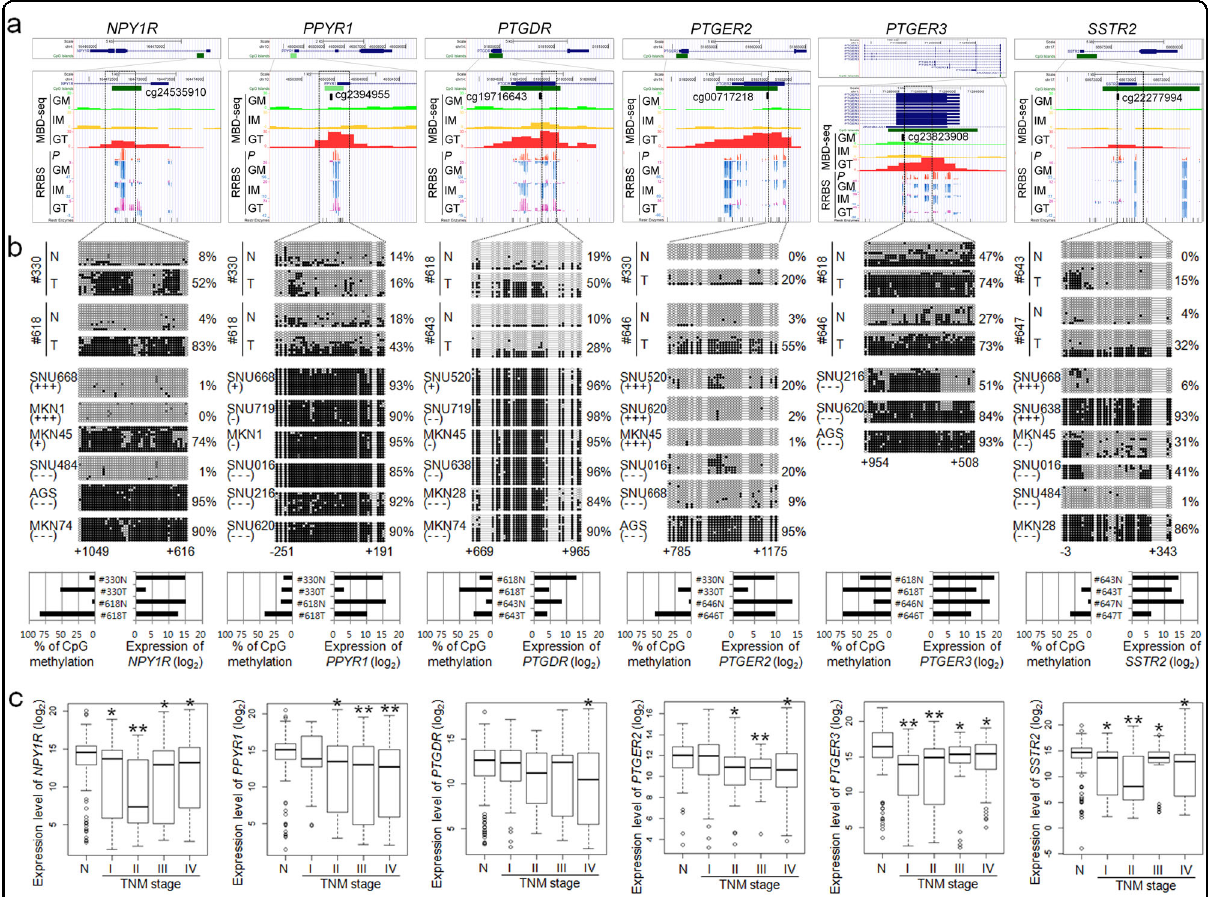
Fig. 5 Methylation and expression analysis of six hypermethylated genes. a Methylation signatures at the promoter regions of the six hypermethylated genes from the MBD-seq and RRBS data. b Comparison of promoter methylation and expression of each gene in two sets of paired gastric tumor tissues. Promoter methylation was estimated by bisul fi te sequencing, and expression was estimated with a real-time qRT-PCR analysis. c Comparison of the expression levels of the six genes between gastric tumor and normal tissues in the CNUH cohort using a real-time qRT-PCR analysis. All analyses were performed by Student ’ s paired t